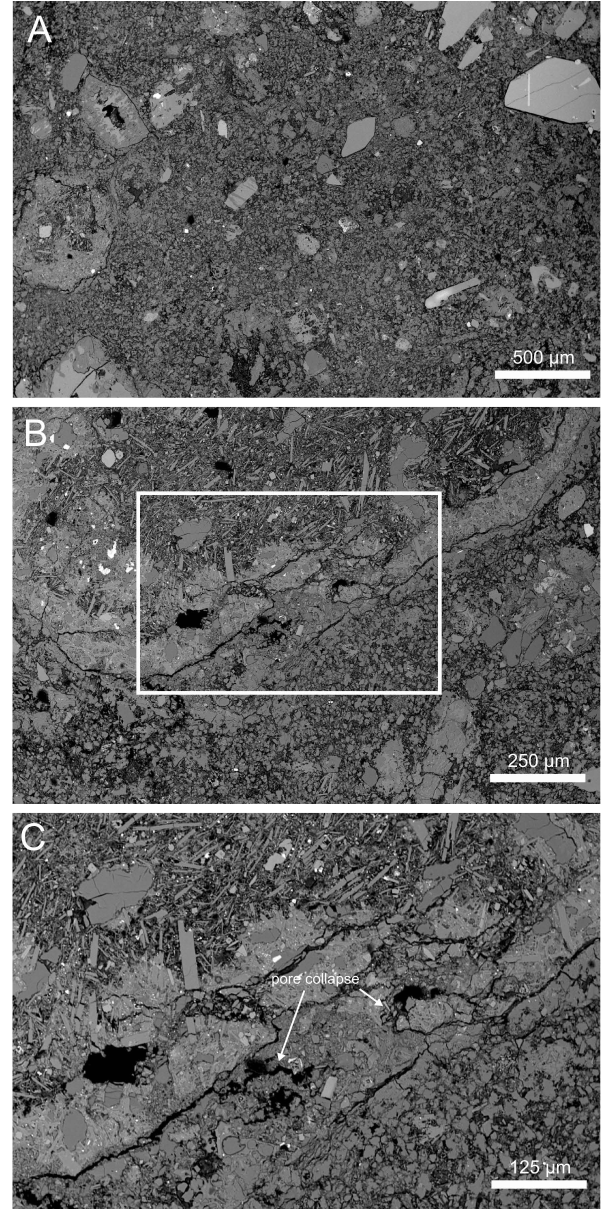
Fig. 11. Scanning electron microscope images of an as-collected sample of Neapolitan Yellow Tuff taken beyond P ∗ . (A) shows an overview of the post- P ∗ microstructure at a low magnification. (B) and (C) show detailed evidence of pore collapse (indicated by the white arrows). (C) is a zoom of the white box shown in (B) .